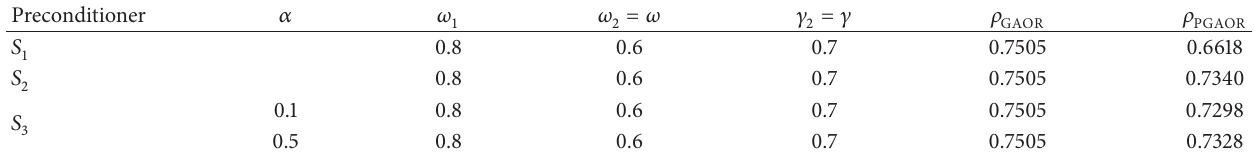
Table 2: Spectral radii of GAOR method and PGAOR